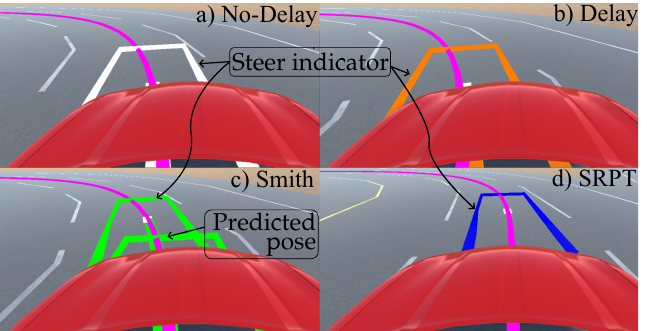
Figure 5. Vehicle perspective in ( a ) no-delay mode, ( b ) delay mode, ( c ) Smith predictor mode, and ( d ) SRPT mode.